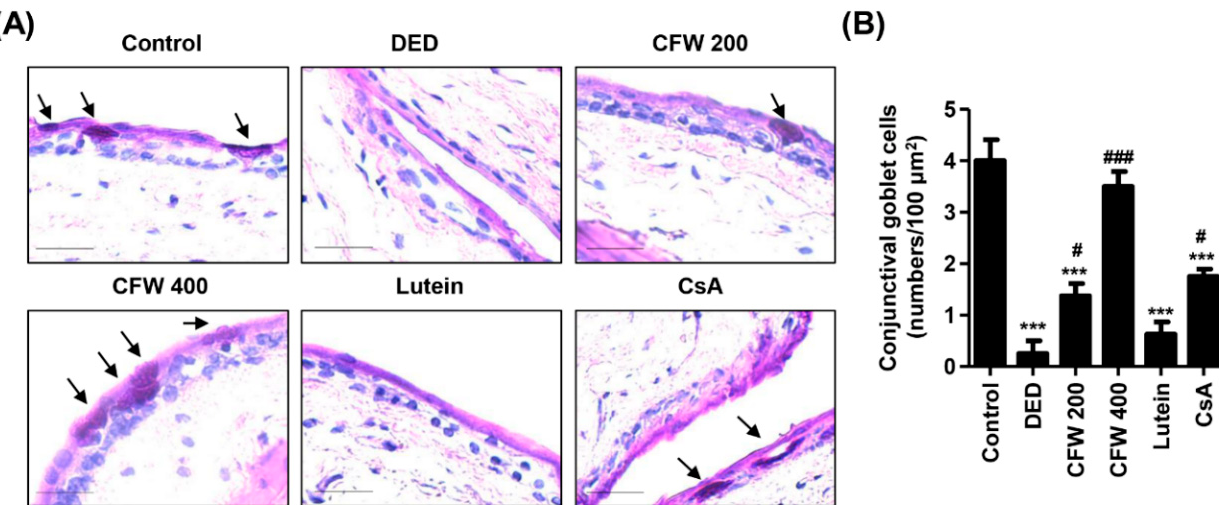
Figure 3. Effect of oral supplements of CFW on conjunctival goblet cell population in PM 2.5 -induced DED rats. ( A ) Representative images of PAS-stained images of conjunctival sections ( n = 4). Black arrows indicate the PAS-stained goblet cells, which appeared a strong violet color. Scale bar, 25 µ m. ( B ) The numbers of goblet cells of 100 µ m 2 in five different sections were counted. The data are expressed as the means ± standard deviation ( n = 10). *** p < 0.001 compared to control group. # p < 0.05 and ### p < 0.001 compared to the PM 2.5 -induced DED group.